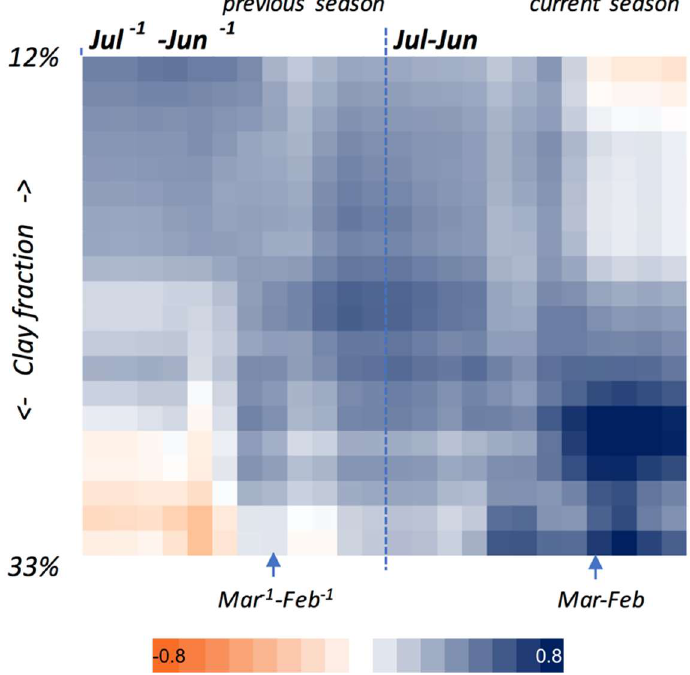
Figure 3. The correlation strength between the yearly accumulated FAPAR (July to June the following year) vs the monthly moving window of the accumulated precipitation over 12 months from one year prior the start, up to the end of the growing season, at all sites (60) over the period 2000–2014, by clay fraction. The red colors represent negative Pearson correlation coefficient values, and the blue colors give positive values. The lighter the shade, the weaker the correlation.